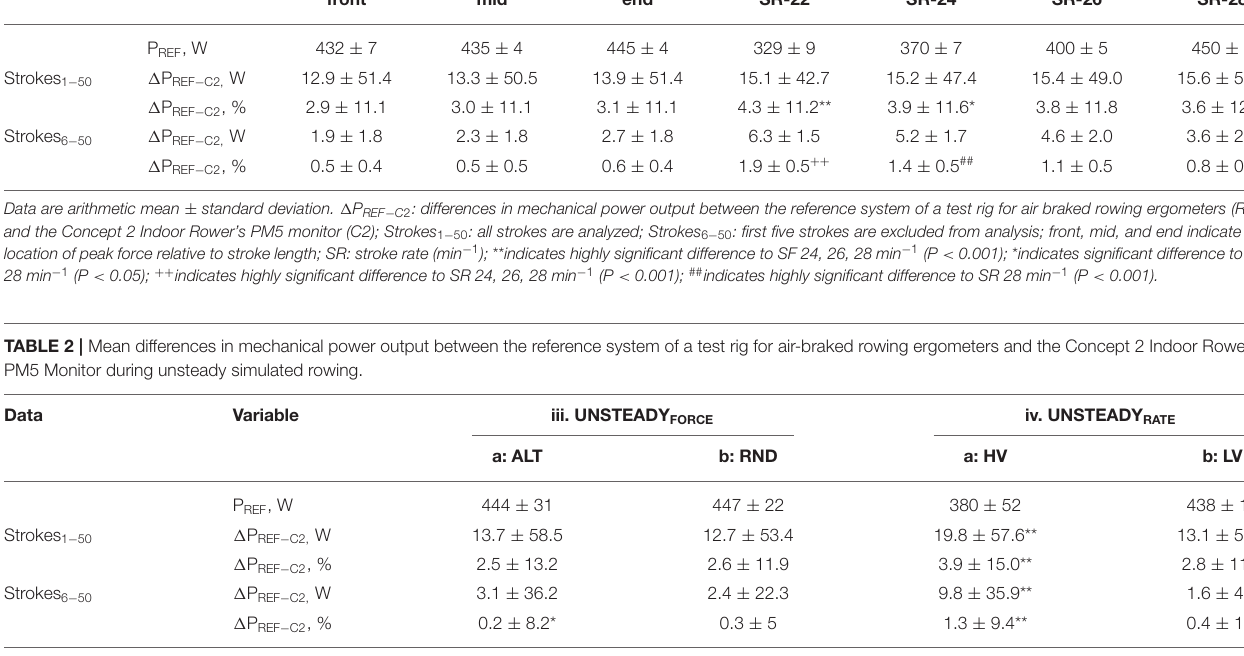
TABLE 1 | Mean differences in mechanical power output between the reference system of a test rig for air-braked rowing ergometers and the Concept 2 Indoor Rower’s PM5 Monitor during steady simulated rowing. Data